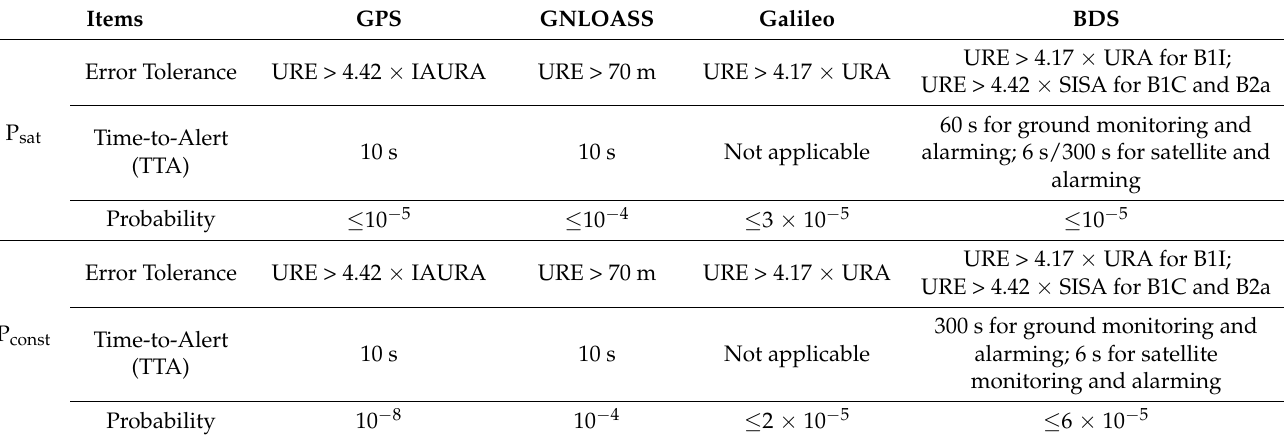
Table 1. GNSS integrity performance in ICAO